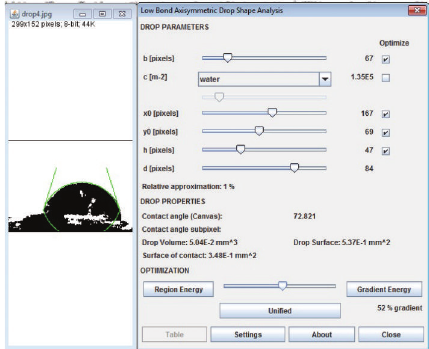
Figure 6: Measurement of contact angle using drop analysis plug-in of Imagej 1.64r software of the same sample.